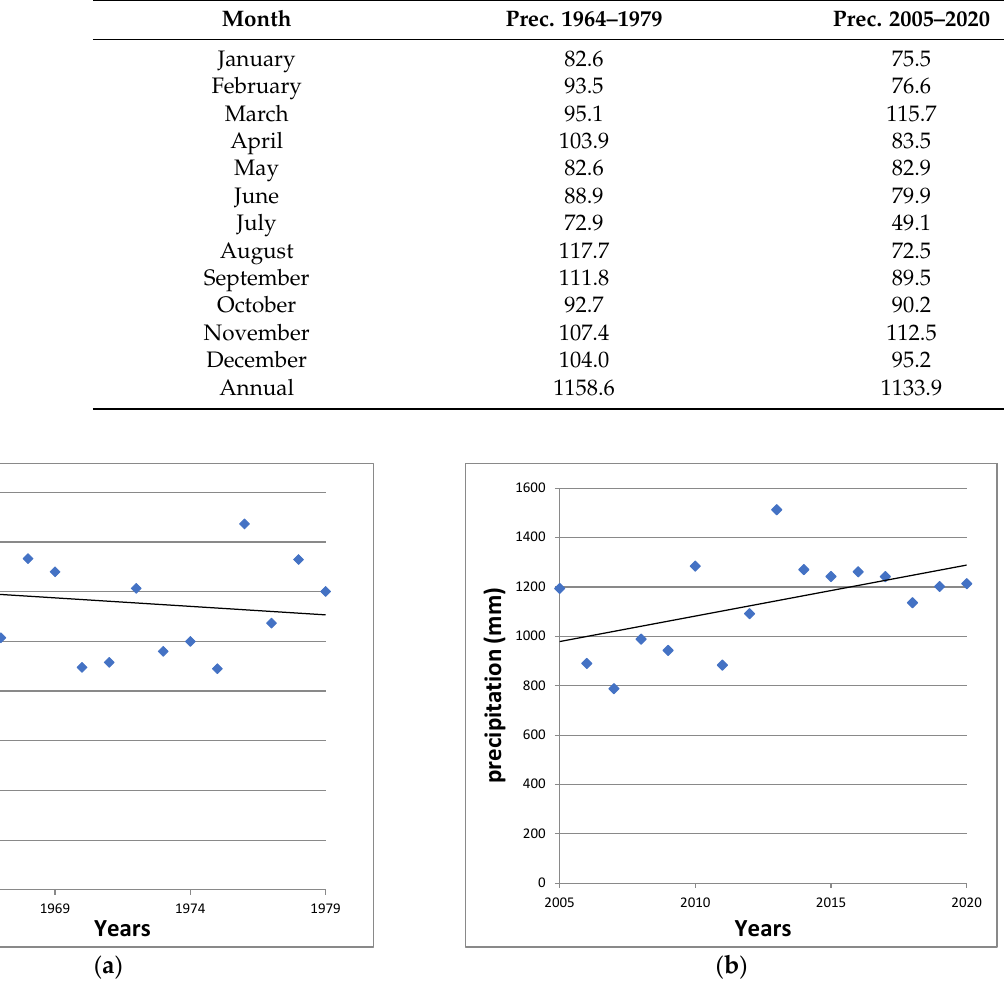
Table 3. Results of monthly precipitation interpolations averaged over the upper Potenza River basin.